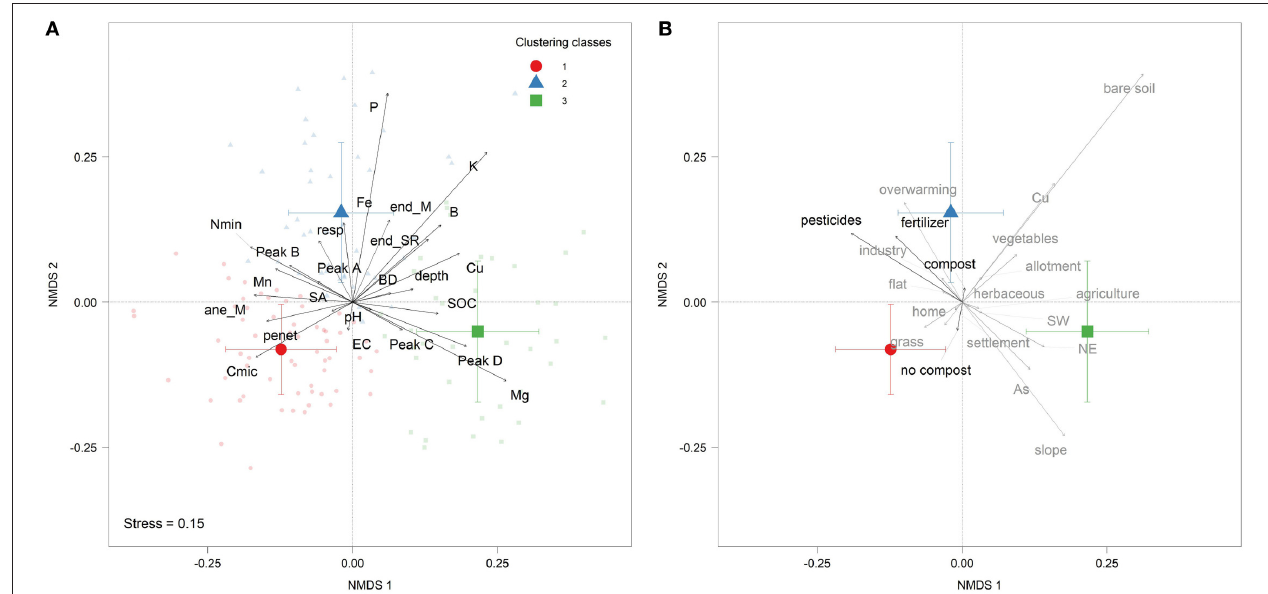
FIGURE 3 | (A) Multivariate NMDS ordination of significant (PERMANOVA, Table S1) measures of soil quality (MSQ). Colors and symbols correspond to different groups of soil quality based on a fuzzy clustering. (B) Biplot of management (black) and garden characteristics (gray) fitted on the NMDS ordination of plot (A) . Only significant variables from PERMANOVA p ≤ 0.05 are displayed in (B) , while MEM were excluded. ane_M, anecic biomass; end_M, endogeic biomass; end_SR, endogeic species richness; resp, basal respiration; penet, penetration resistance; BD, bulk density; SA, stable aggregates.